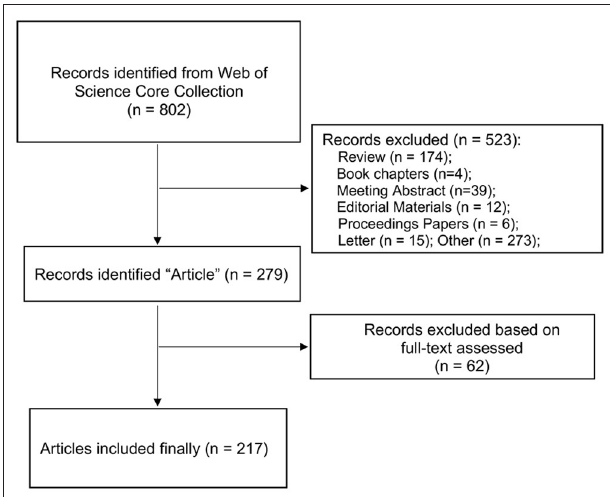
FIGURE 1 | Flowchart of included and excluded studies.